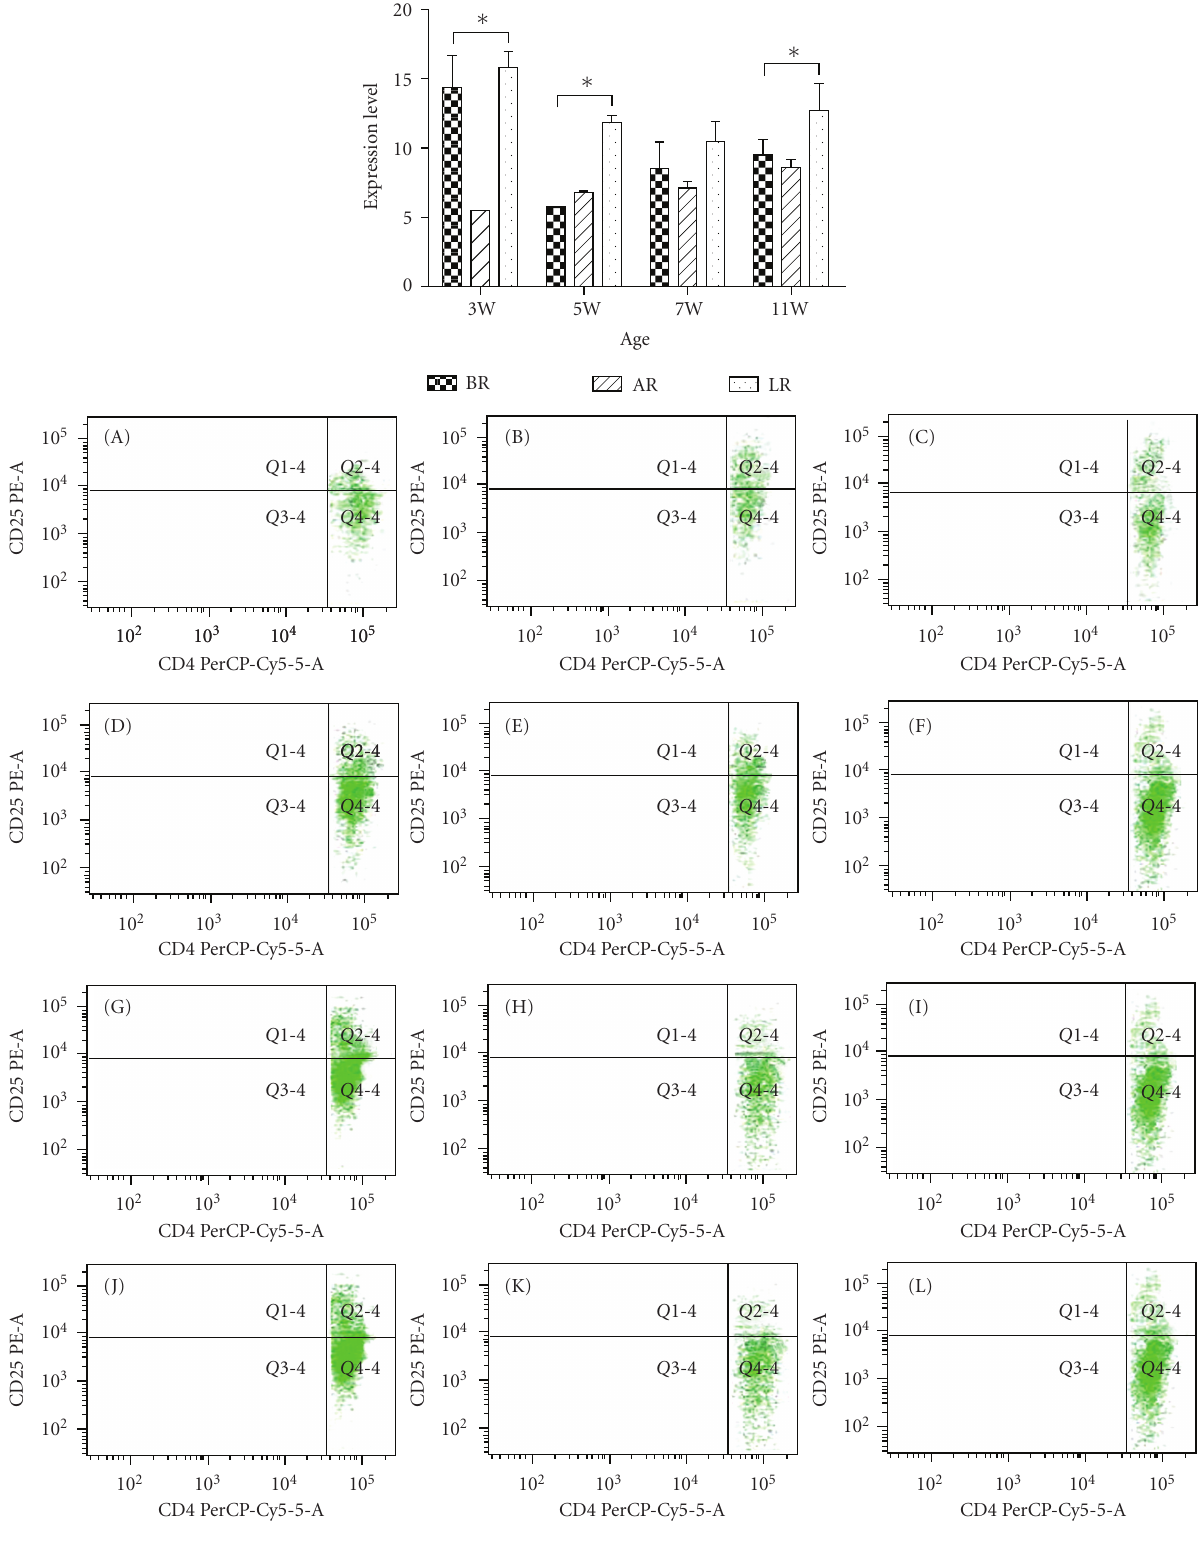
Figure 2: Flow cytometric analyses of CD3 + CD4 + CD25 + T-cells in PPs of each group in di ff erent development stages (Mean ± SD). In order to investigate T cells proliferation and di ff erentiation in three di ff erently fed groups, we examined the phenotype of CD3 + CD4 + T cells subpopulation in the PPs by assessing the relative proportions of CD3 + CD4 + CD25 + T cells. The results showed that the group of LR rats had a higher relative proportion of CD3 + CD4 + CD25 + T cells in PPs (b A: BR at W3, B: AR at W3, C: LR at W3, D: BR at W5, E: AR at W5, F: LR at W5, G: BR at W7, H: AR at W7, I: LR at W7, J: BR at W11, K:AR at W11, L: LR at W11). ∗ P < .